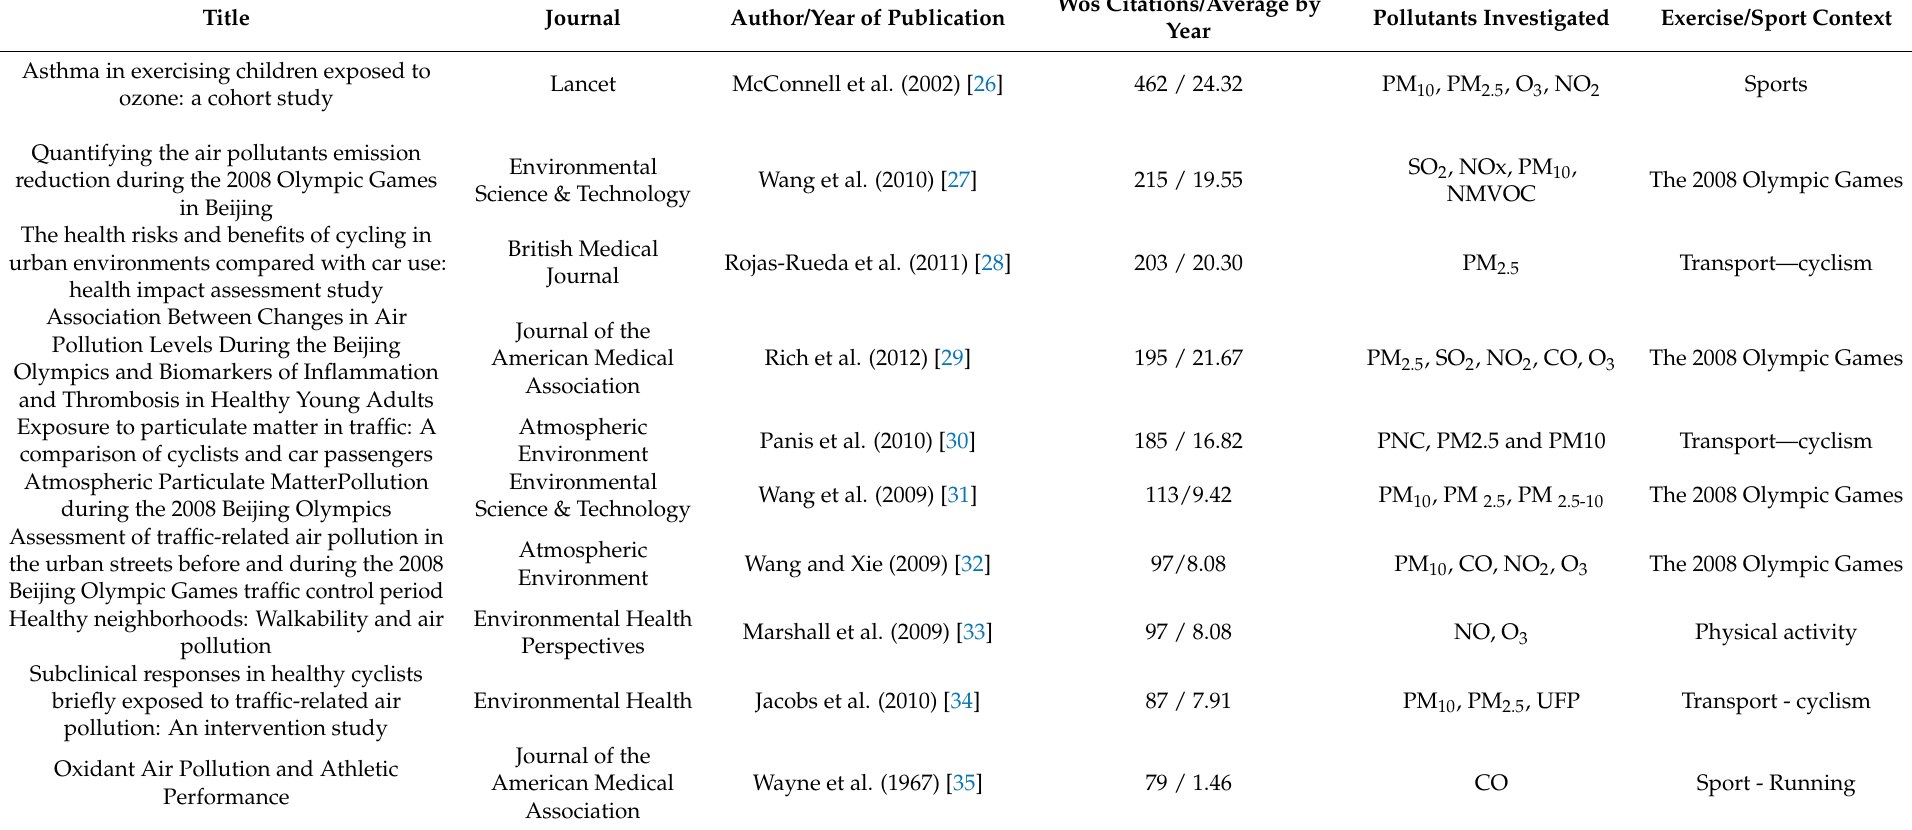
Table 2. Publications with the highest number of citations in